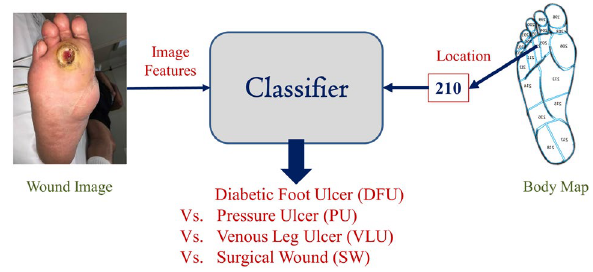
Figure 1. Workflow of this